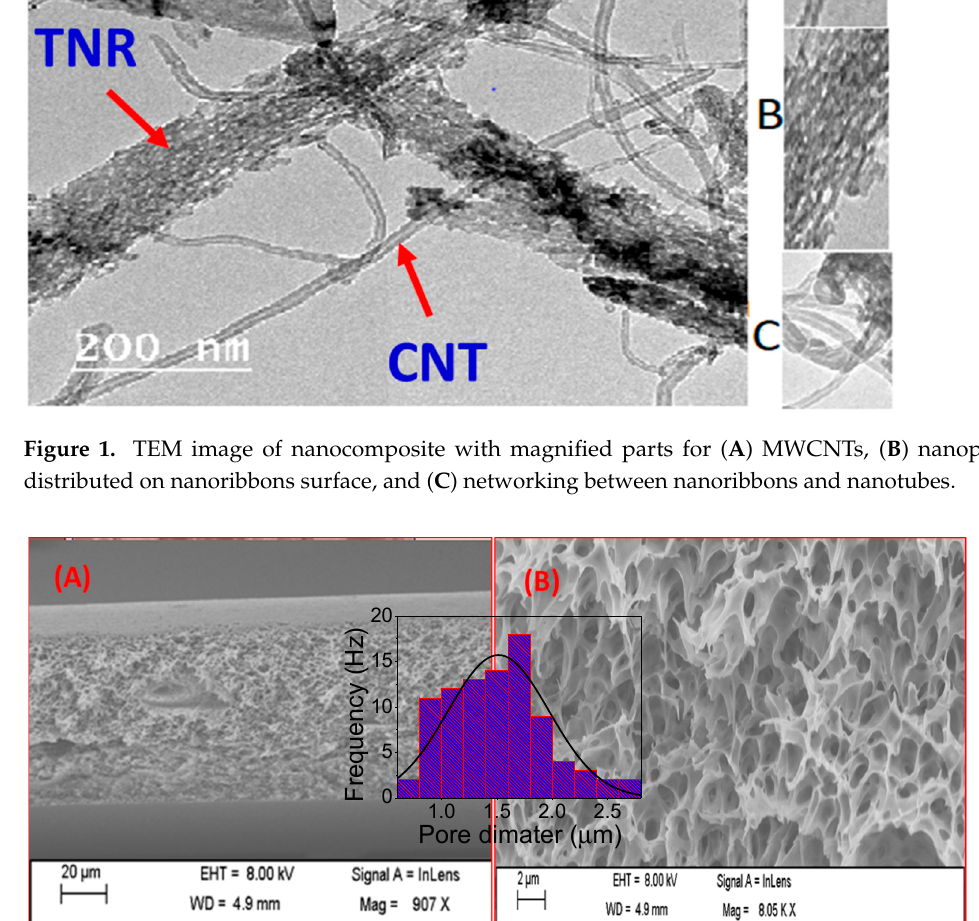
Figure 1. TEM image of nanocomposite with magnified parts for ( A ) MWCNTs, ( B ) nanopits dis- tributed on nanoribbons surface, and ( C ) networking between nanoribbons and nanotubes.